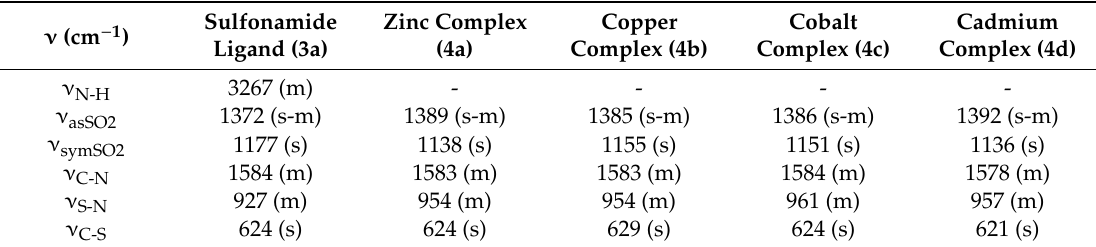
Figure 1. FT-IR spectra of sulfonamide ligand 3a, zinc (II) complex (4a), copper (II) complex (4b), cobalt (II) complex (4c) and cadmium (II) complex (4d). Table 1. Representative bands of sulfonamide ligand 3a and its complexes with divalent ions Zn 2 + , Cu 2 + , Co 2 + and Cd 2 + .